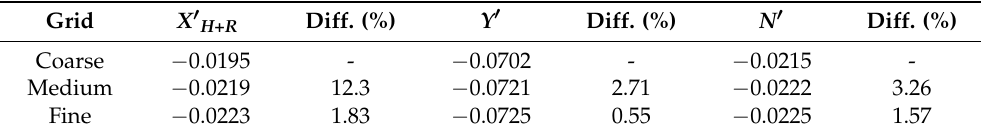
Table 7. Grid independence analysis for static drift motion by water–air flow simulation.